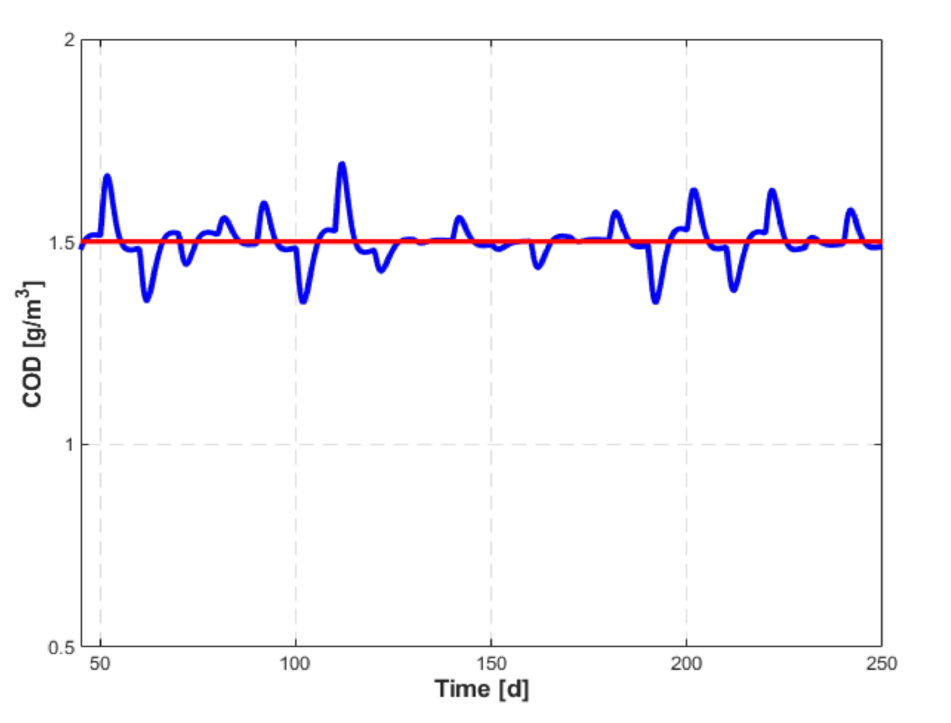
Figure 16. Evolution of the setpoint (red) and the controlled variable